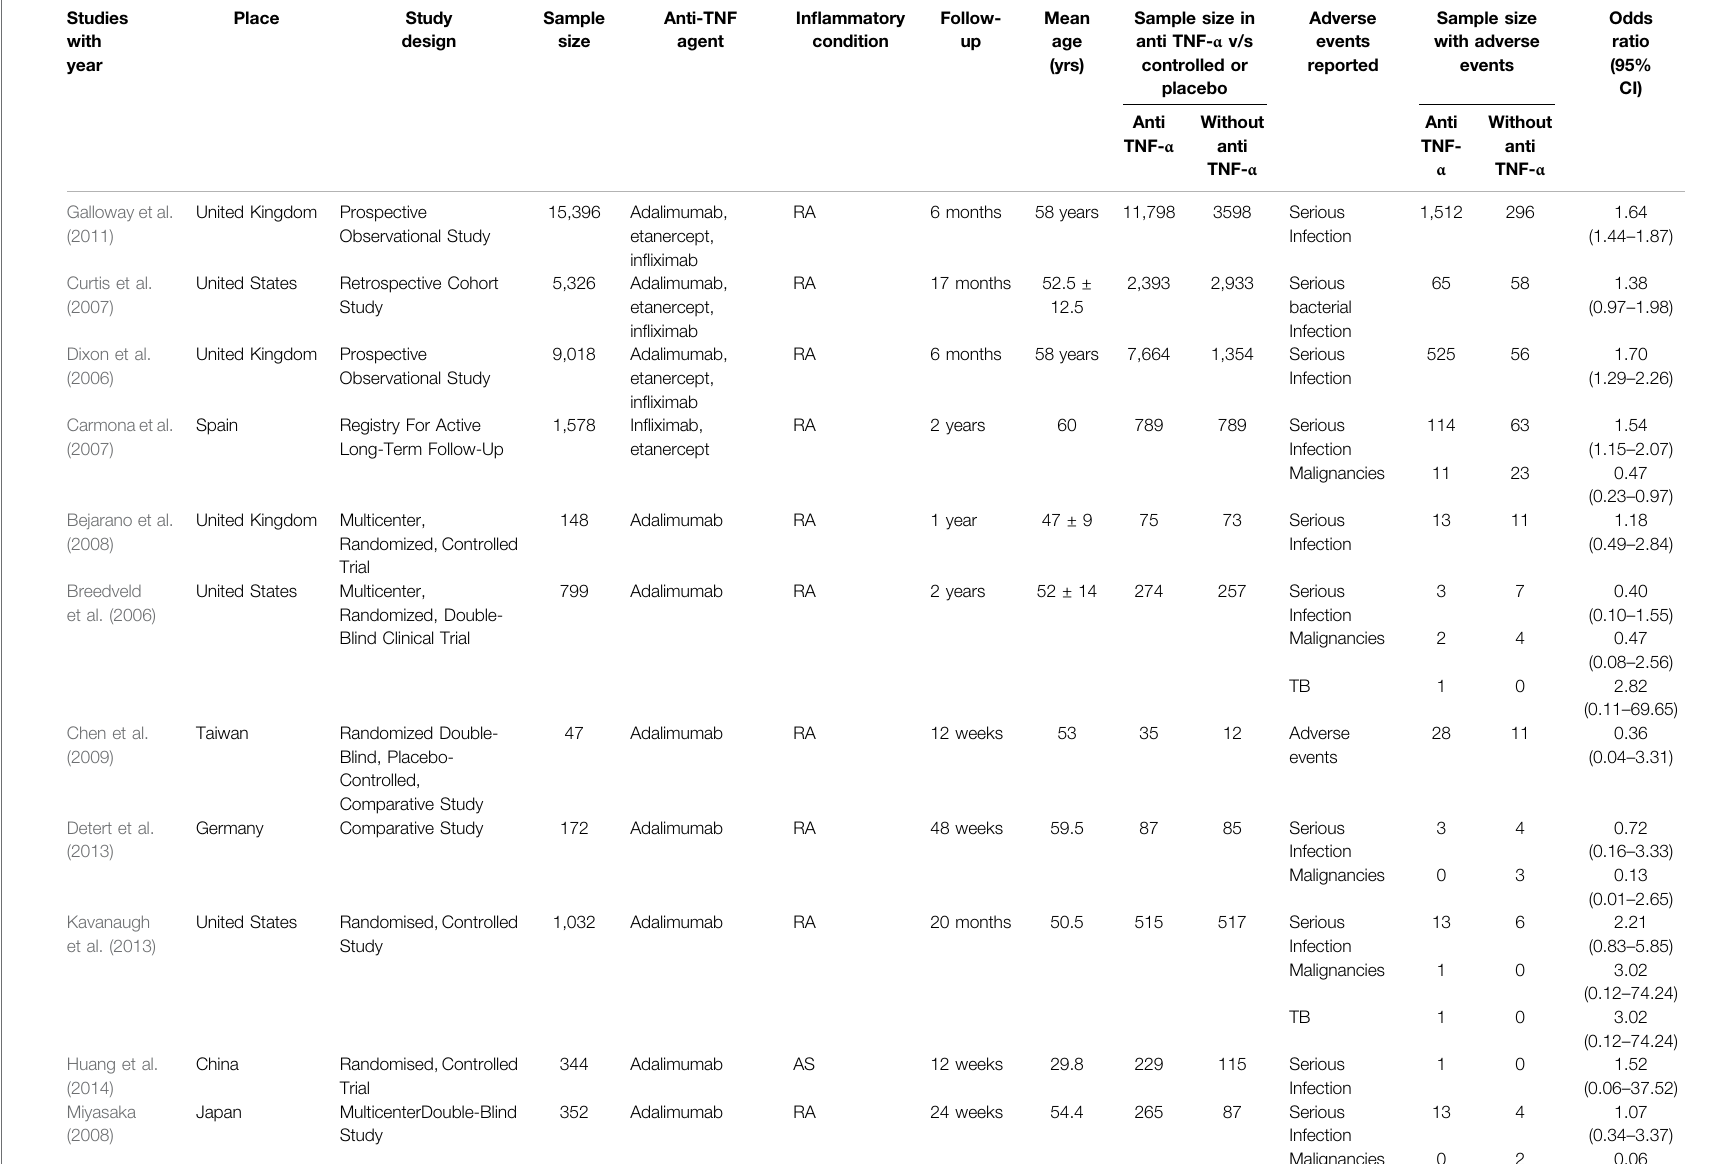
TABLE 1 | Demographic Details of Included